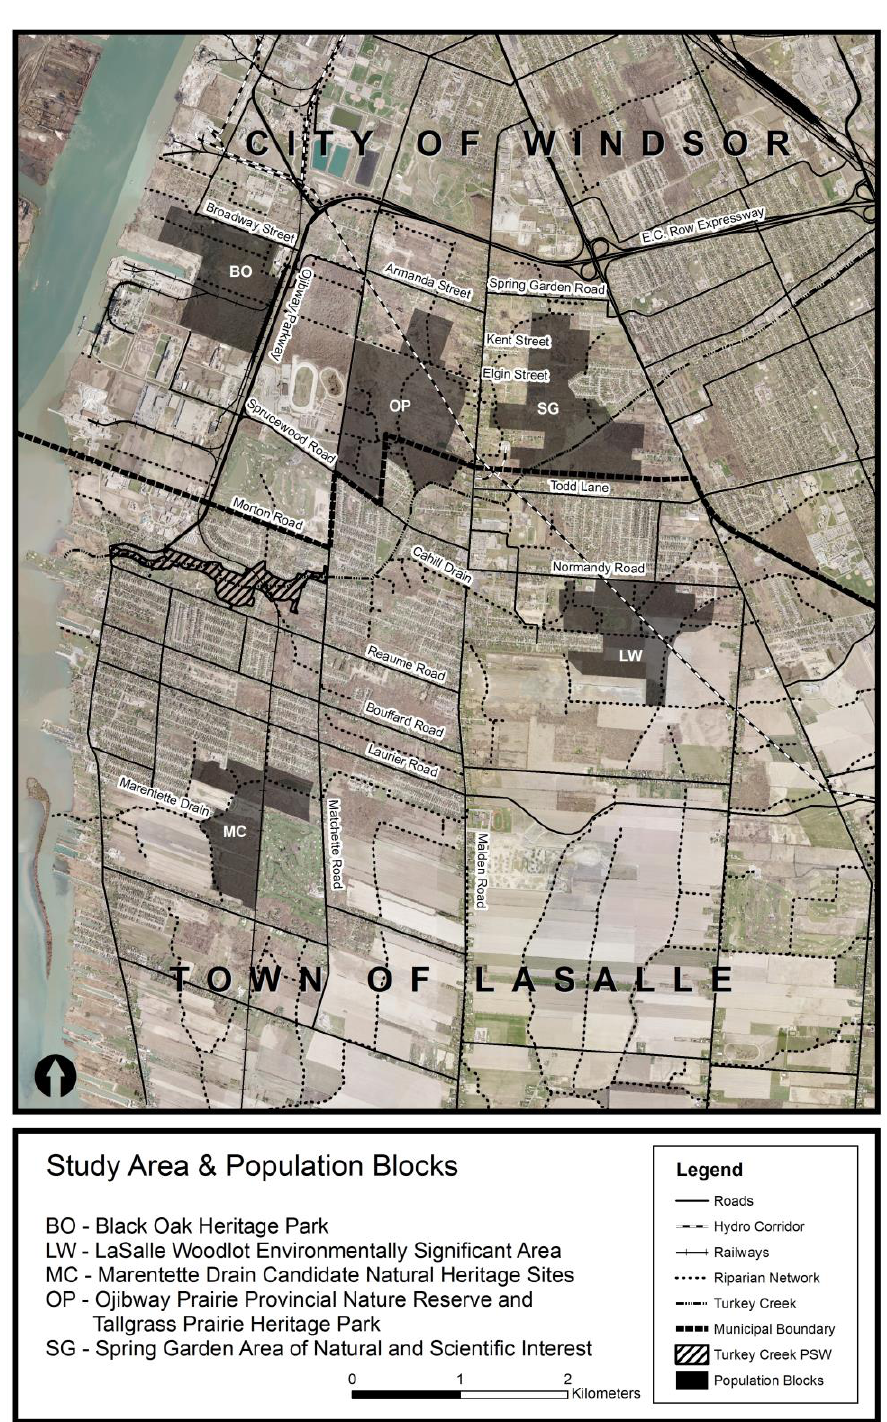
Figure 2. Study area and population blocks used to model potential connectivity pathways for the Massasauga rattlesnake in an urban park system in southwestern Ontario. The study area is bounded by the Detroit River to the east.